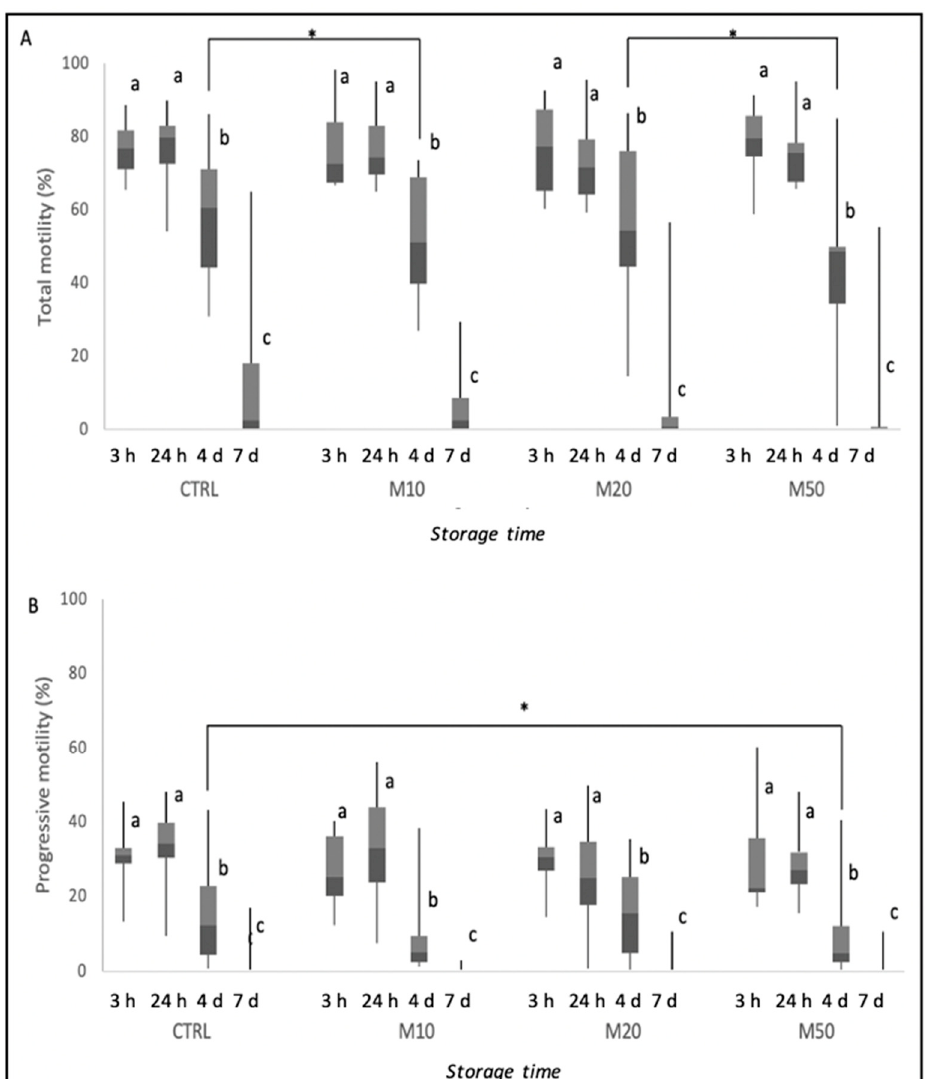
Figure 1. Total ( A ) and progressive motility ( B ) of dog semen ( n = 9) diluted with only egg-yolk tris-citrate glucose (YET-G; CTRL) or with EYT-G with the addition of three different concentrations (10, 20 and 50 µ L/mL) of aqueous extract of Maca (M10, M20 and M50) stored at refrigeration temperature (4 °C) and evaluated at 3 h, 24 h, 4 d and 7 d of storage. Asterisk above the bar indicates statistical difference between groups at p ≤ 0.05. The letters a, b and c indicate statistically significant differences at p ≤ 0.05 between time points within each group.